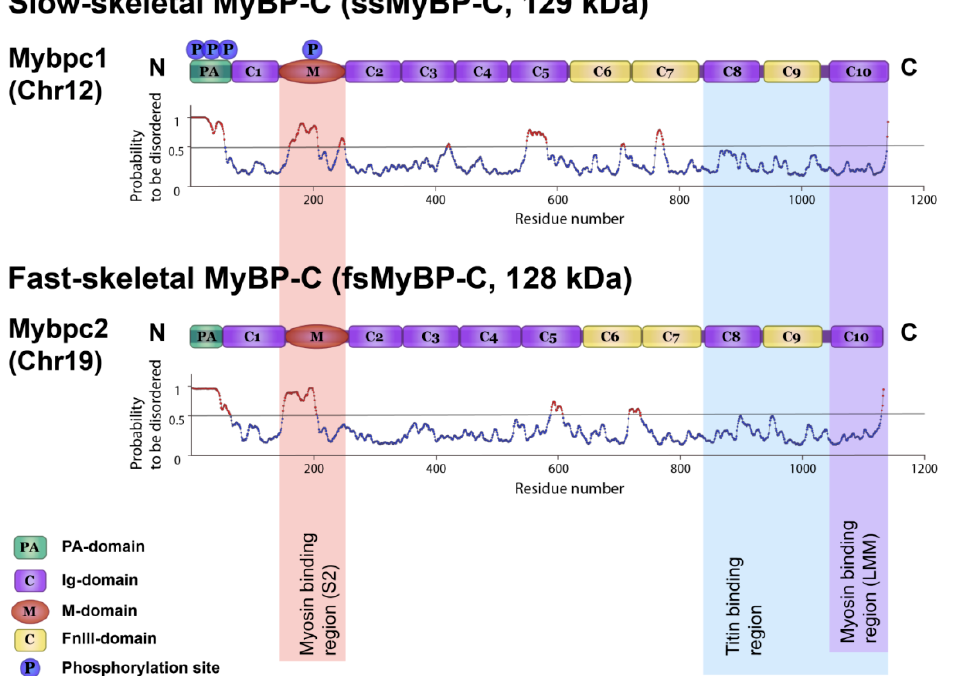
Figure 10. sMyBP-C domain structure schematic aligned with the protein disorder prediction plots by the IsUnstruct program [46]. Probabilities of ≥ 0.5 mean a disorder. Upper, ssMyBP-C paralog; program [46]. Probabilities of ≥ 0.5 mean a disorder. Upper, ssMyBP-C paralog; lower, fsMyBP-C lower, fsMyBP-C paralog.